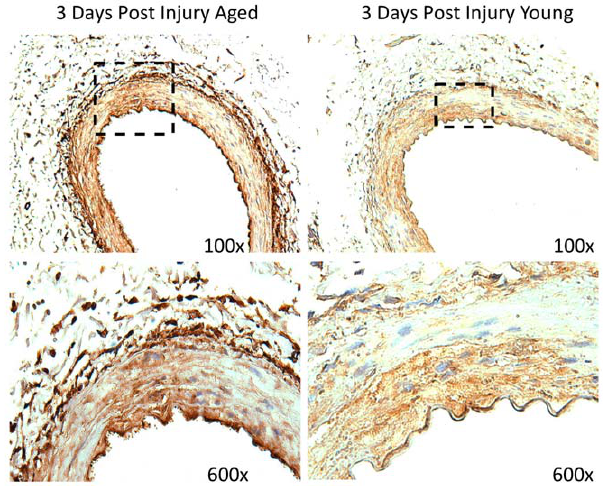
Figure 5. Myl9 immunostaining of old (22 months) and young (3 months) injured rat iliac arteries. Shown are representative images of young and old iliac arteries 3 days post injury, immuno- stained for Myl9. Results confirm over-expression of Myl9 in the older injured group and point to concentration of Myl9 expression in the smooth muscle layer of the iliac arteries during this post injury transition period.